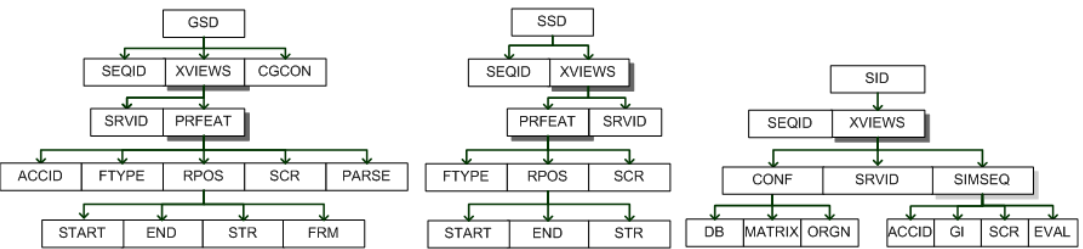
Figure 2: Tree-view of the schemas defined in the Information Schema Definition module. Elements in shaded boxes indicate potential recurrent appearance within the XML